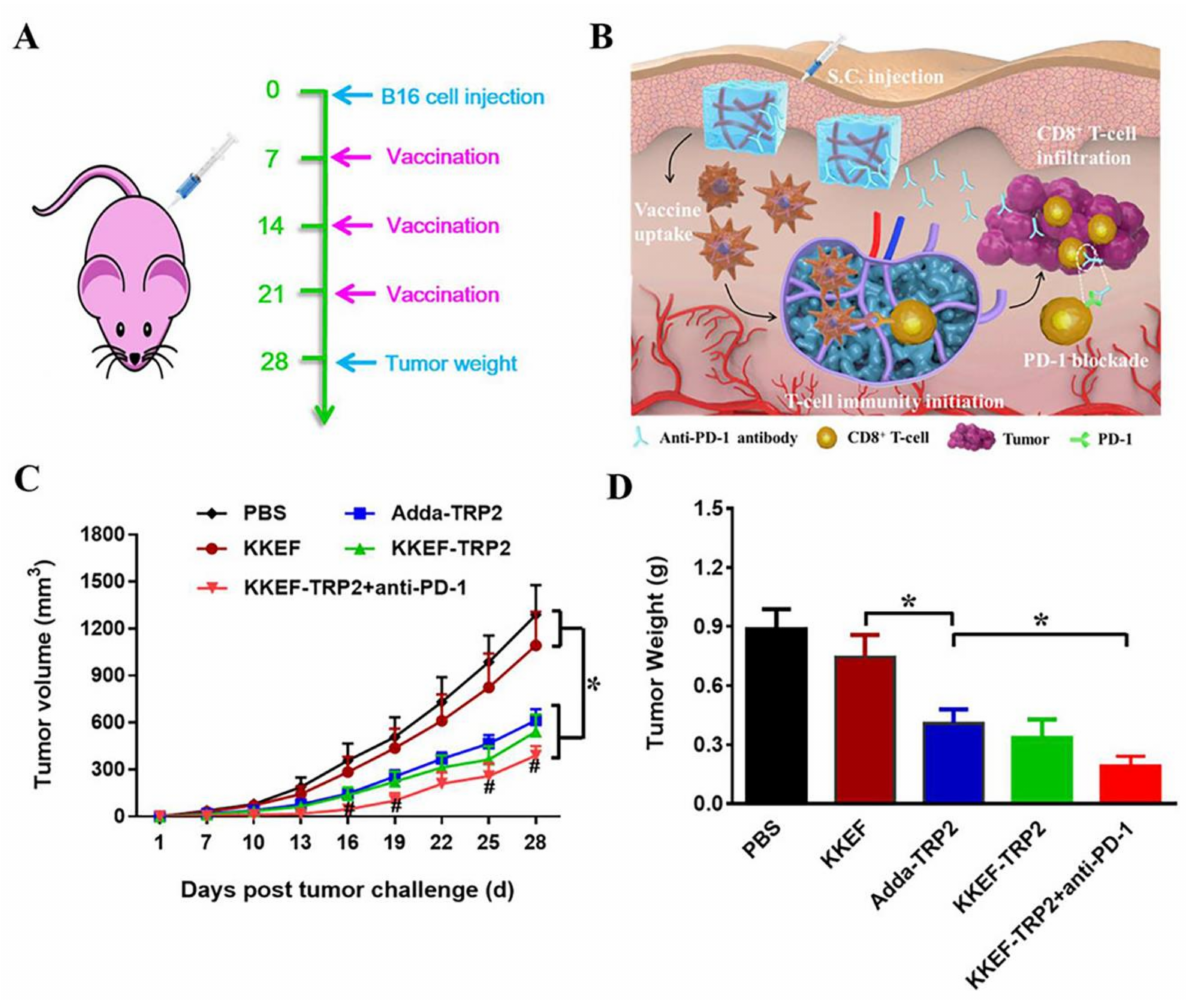
Figure 4. KKEF-TRP2 vaccine increases the therapeutic antitumor effect in melanoma model. ( A ) The protocol of tumor cell inoculation and vaccination. ( B ) Schematic of antitumor T-cell response induced by KKEF-TRP2 hydrogel through efficient peptide delivery and combination immunotherapy with anti-PD-1. ( C ) The tumor volume in the time range of 28 days after cell inoculation. ( D ) The mass weight of excised tumors at day 28. Values represent mean ± SDs ( n = 6) from at least three independent experiments. * p < 0.05, between indicated groups; # p < 0.05, between KKEF-TRP2 and KKEF-TRP2+anti-PD-1 groups. Reproduced with permission from [85], John Wiley and Sons,